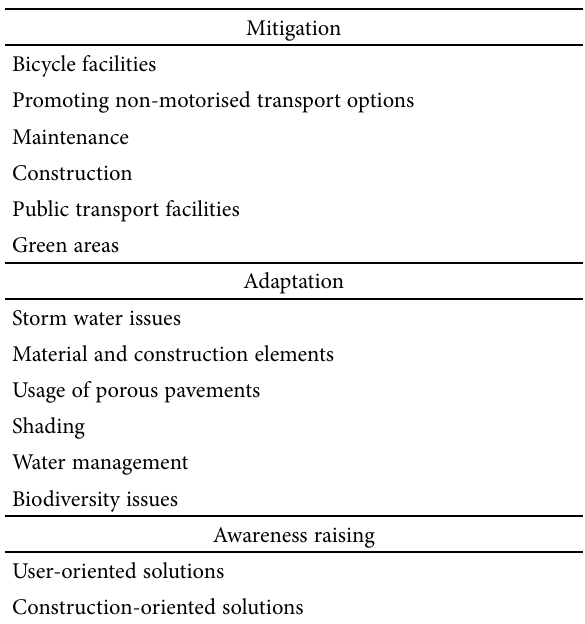
Table 1. Evaluated subsystems regarding mitigation, adaptation and awareness raising